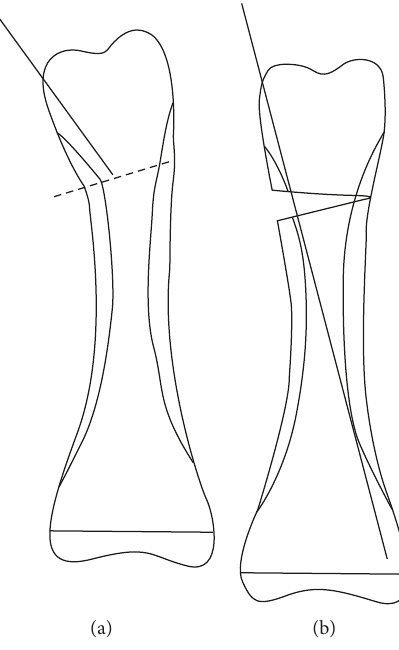
Figure 1: Surgical procedure. (a) Insert a K-wire until just distal to the preplanned osteotomy line (a dotted line). (b) Advance the tip of the K-wire along the radial side of the intramedullary cortex after gradual opening of the osteotomy